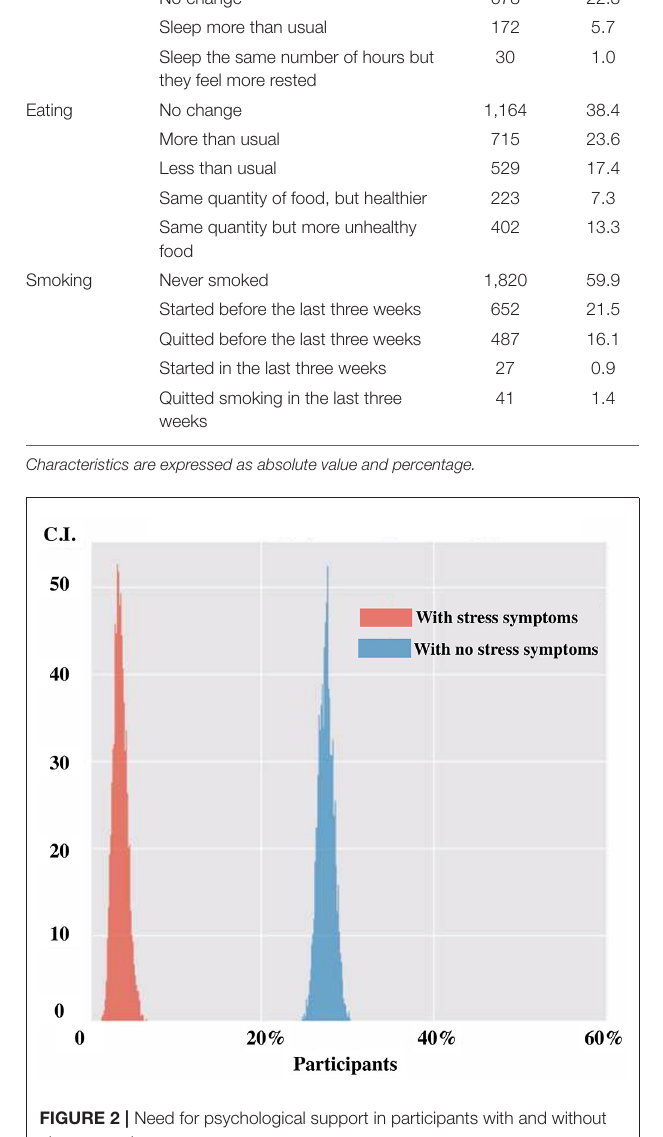
shown to impact physician’s mental health, patients’ care quality, and the efficiency of the healthcare system (20).